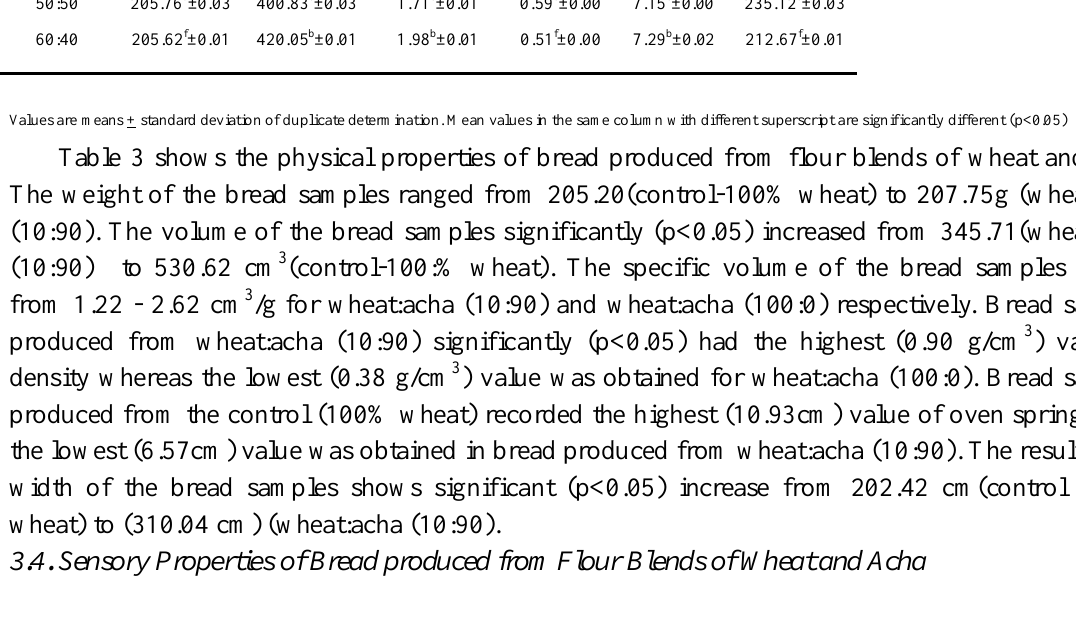
Table 4: Sensory Properties of Bread produced from Flour Blends of Wheat and Acha